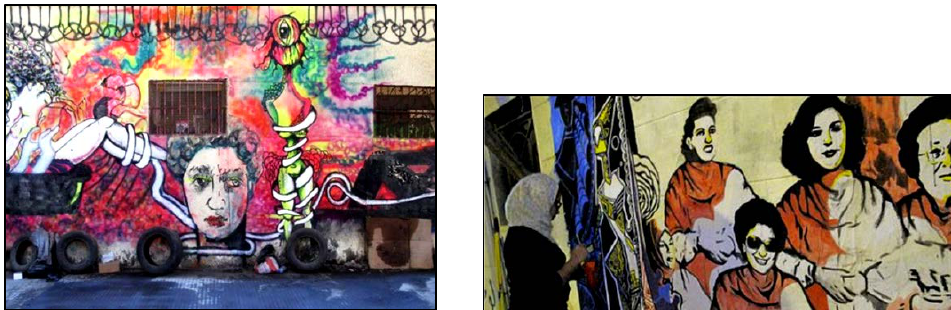
Figure 13&14. Mural paintings executed within the activity of the "Lady of the Wall"